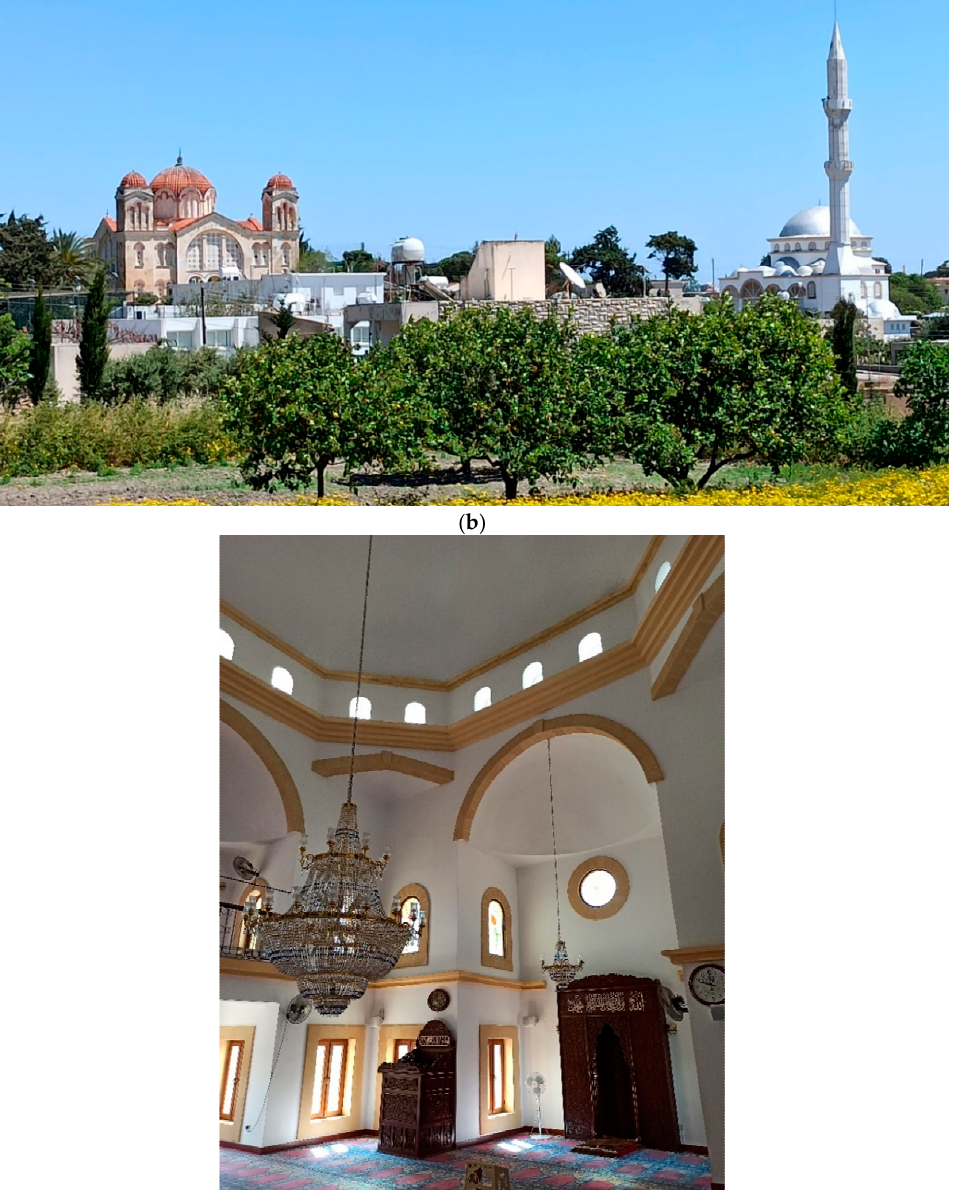
Figure 9. ( a ) Neo-Ottoman type B mosque and Nurettin Ersin Pa ş a mosque, gallery-floor plan (drawing by authors and Mojtaba Karimnezhad, based on a plan from the Evkaf Construction Department). ( b ) Yedikonuk/Ephtakomi, view from north-west onto the new neo-Ottoman mosque (type B; 2006/2008) on the right, and onto the former church of St. George (-1974)/former mosque (1974–2008) on the left(photo: authors). ( c ) Do ğ anköy (Kyrenia), neo-Ottoman type B mosque, 2012, view onto the mihrab (photo: authors).